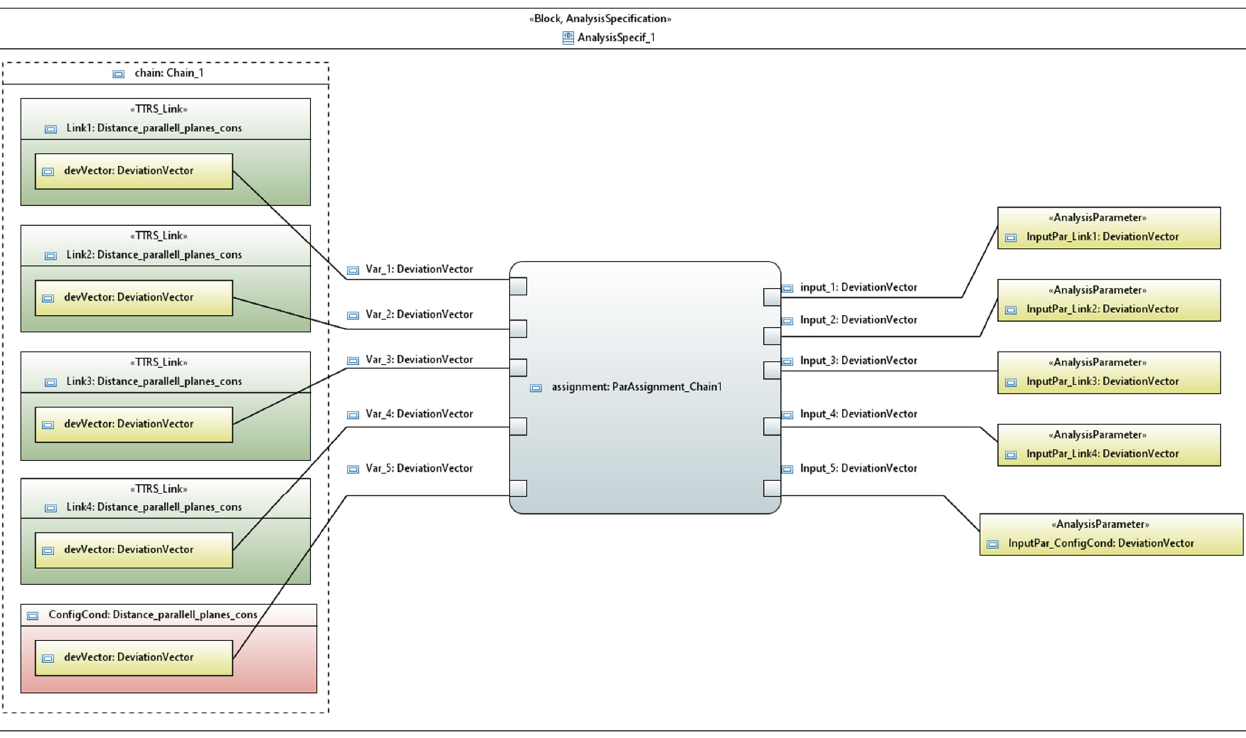
Figure 23. PAR diagram of the AnalysisSpecif_1 Block.